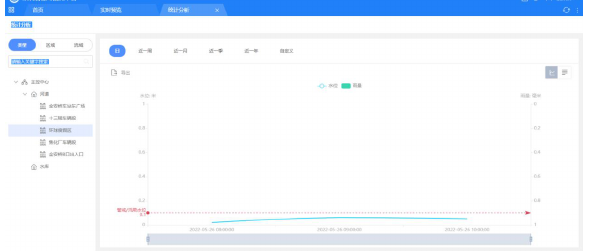
Figure 13 . Monitoring data statistics and early